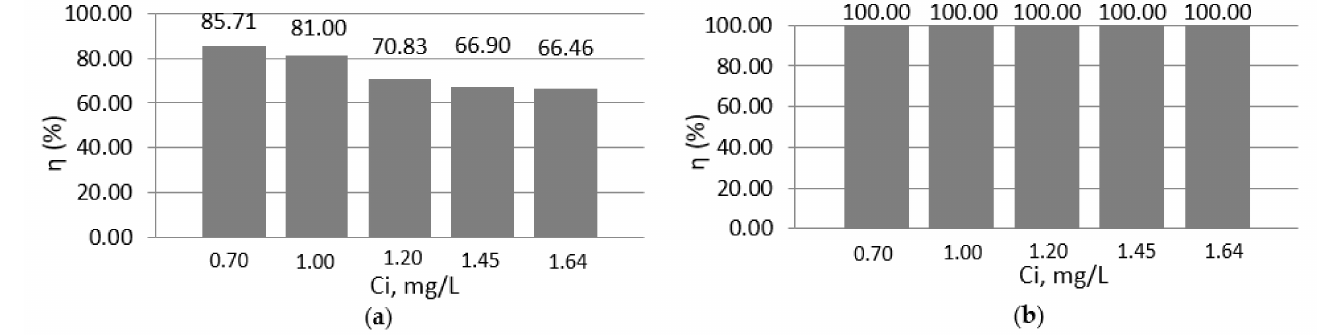
Figure 6. Efficiencies of wastewater treatment in the case of 400 RPM versus initial concentrations at pH 4 ( a ) and pH 6 ( b ).